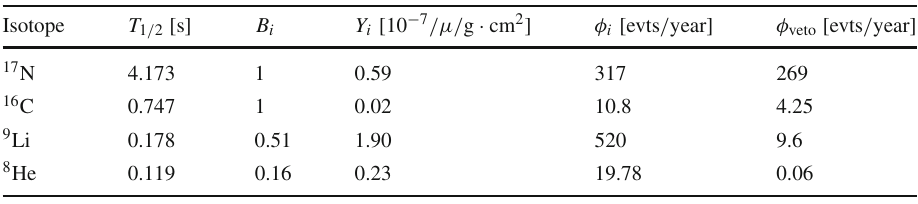
Table 1 Summary of ( β − , n)